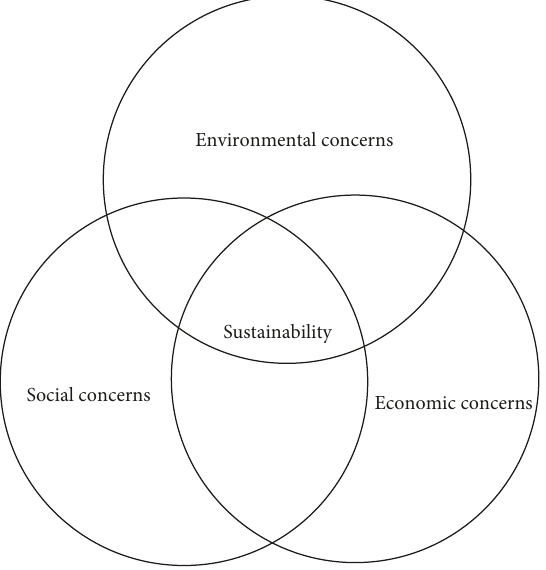
Figure 1: Triple bottom line of sustainability